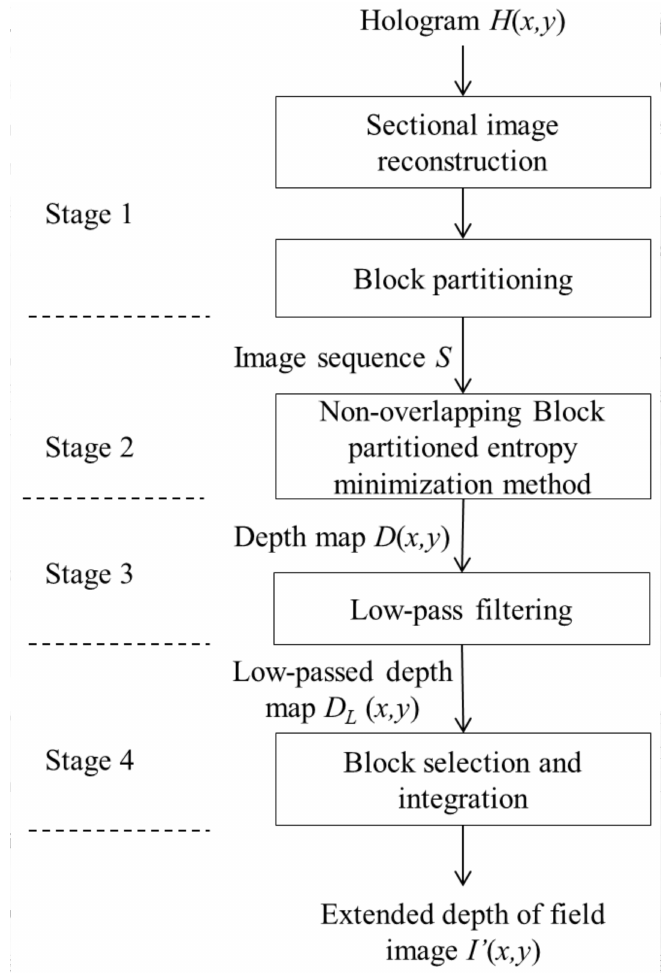
Figure 2. Proposed